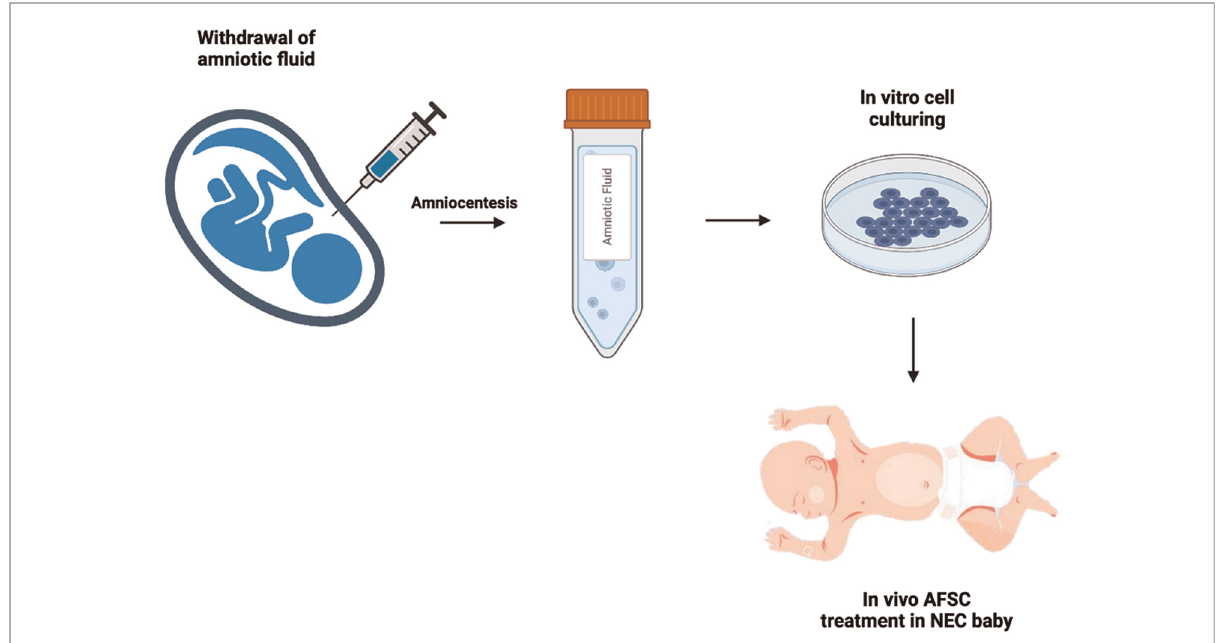
FIGURE 1 Schematic of AFSC collection and administration. Following amniocentesis, amniotic fl uid stem cells are cultured from the amniotic fl uid, then administered to the neonate suffering from